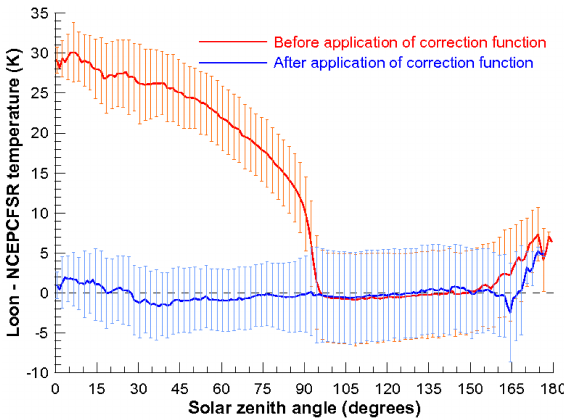
Figure 9. Differences between Loon lift-gas temperatures obtained from selected odd-numbered flights (red traces) and temporally and spatially coincident NCEP–NCAS–CFSR reanalysis temperatures. Mean differences in each 1 ◦ SZA bin are shown with a solid line together with the first standard deviation of the differences as un- certainty bars. Differences after the application of the correction functions are shown in blue.